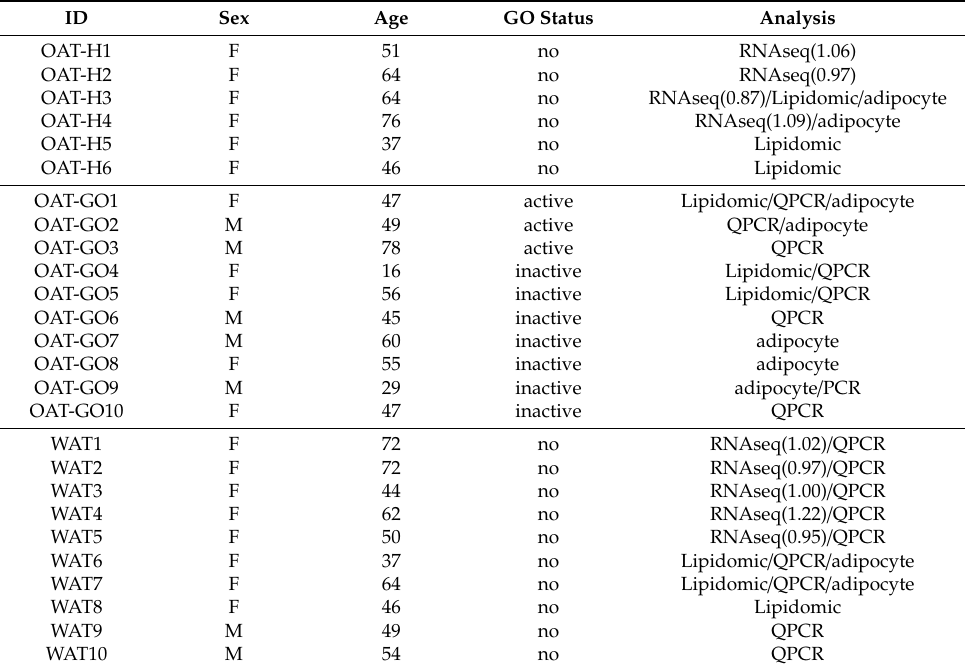
Table 3. Ex vivo samples from WAT, OAT-H and OAT-GO used for this study. ID Sex Age GO Status